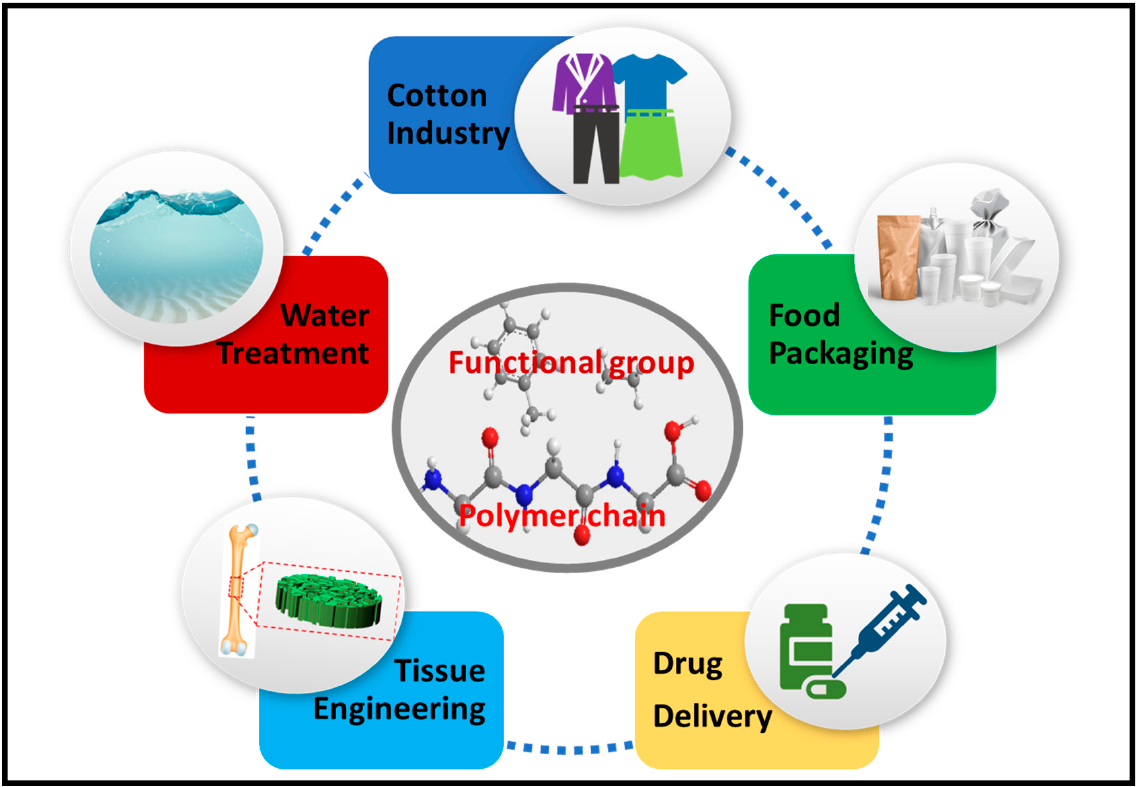
Figure 1. Polymer functionalization and application [35].